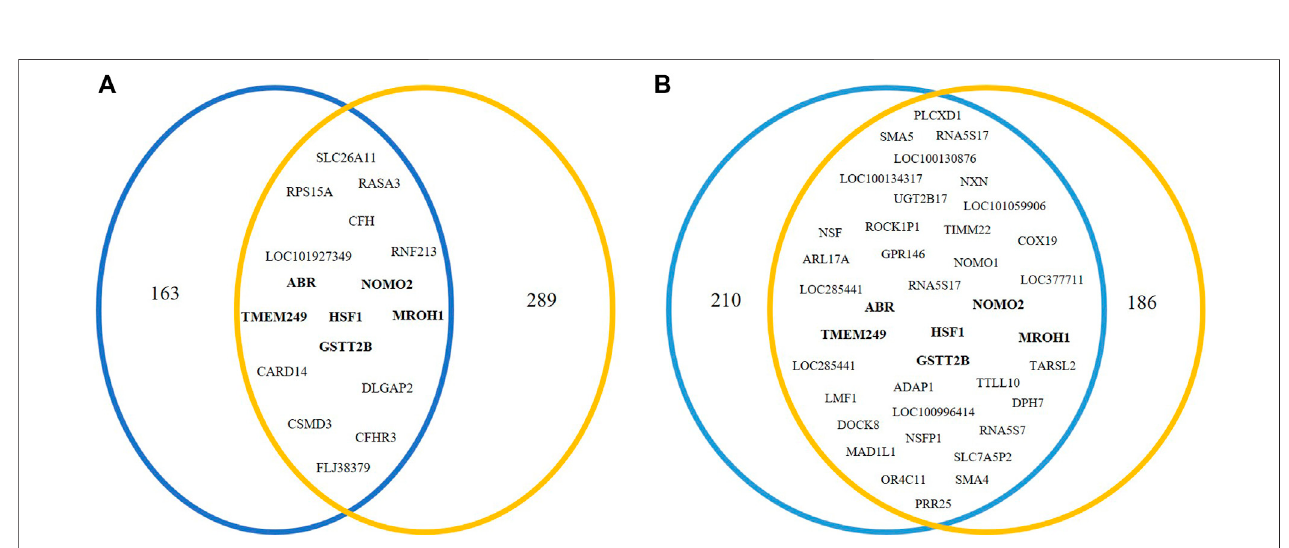
FIGURE2| VenndiagramanalysistoinvestigategenesrelatedtoNACresistance.InNAC-resistantpatients,Venndiagramindicated (A) 17commongenesinpre- NAC-treated patients and (B) 38 common genes in post-NAC-treated patients that were obtained via NextGENe analysis.